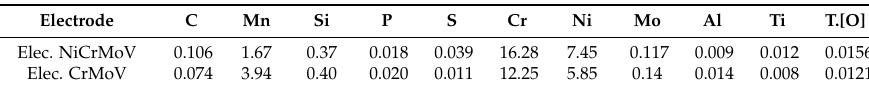
Table 1. Chemical composition of consumable electrode used in present experiment (wt %). Elec.: Electrode, T.: Total.